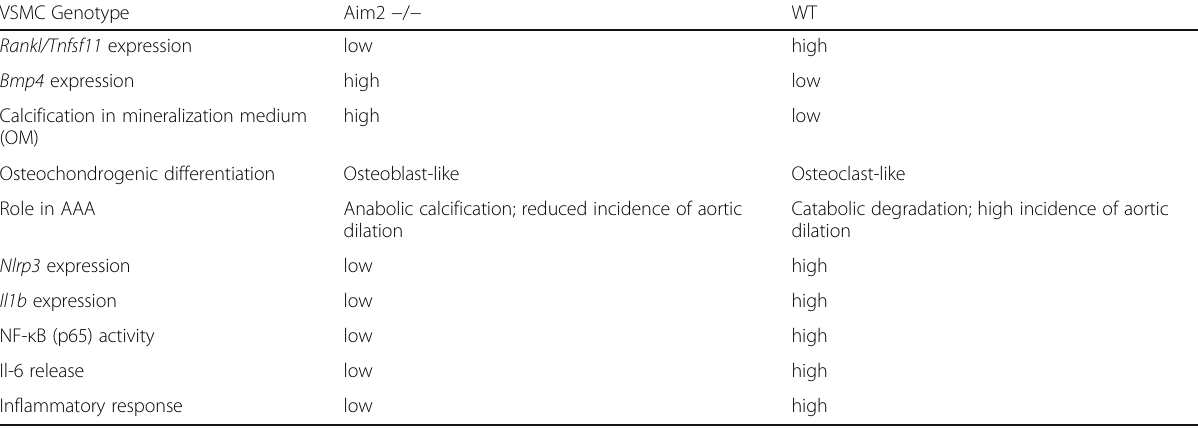
Table 1 Effects of Aim2 expression/knockout on VSMC differentiation and aortic remodeling VSMC